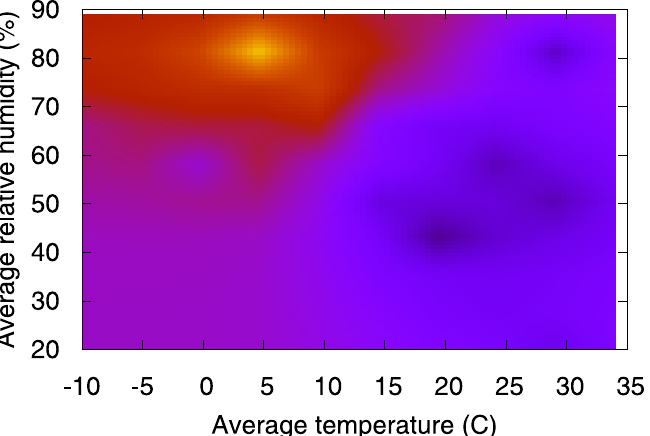
Fig 42. (Color online) the relationship between temperature, relative humidity and velocity. Lighter regions are associated with higher